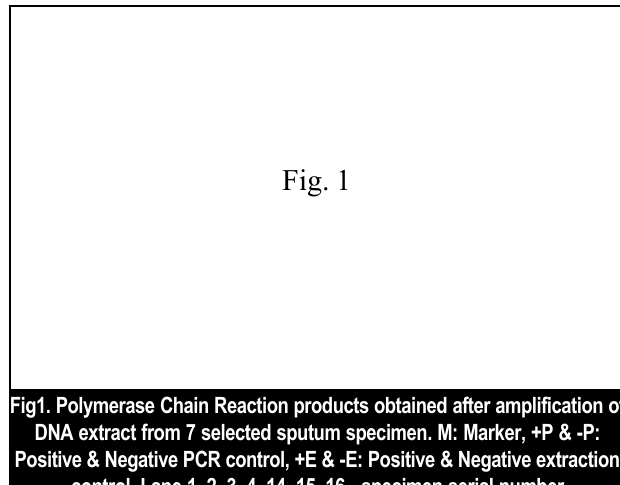
Fig1. Polymerase Chain Reaction products obtained after amplification of DNA extract from 7 selected sputum specimen. M: Marker, +P & -P: Positive & Negative PCR control, +E & -E: Positive & Negative extraction control, Lane 1, 2, 3, 4, 14, 15, 16 - specimen serial